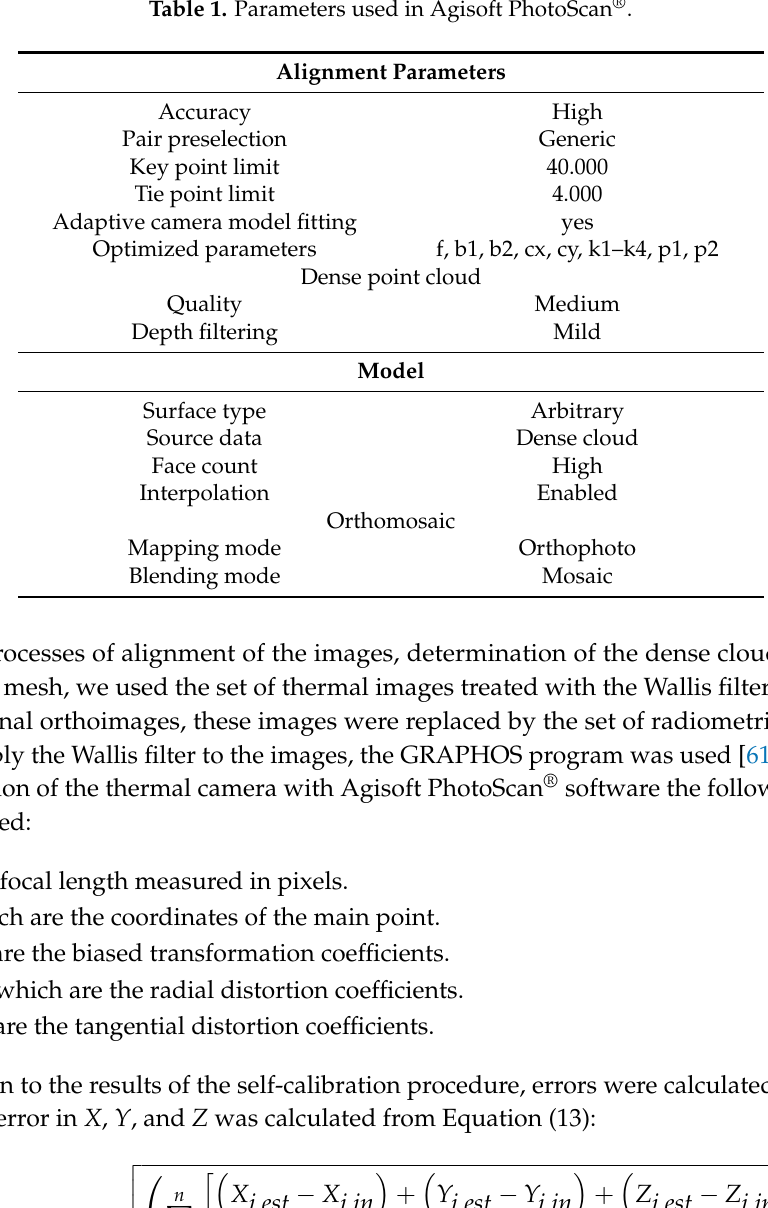
Table 1. Parameters used in Agisoft PhotoScan ®